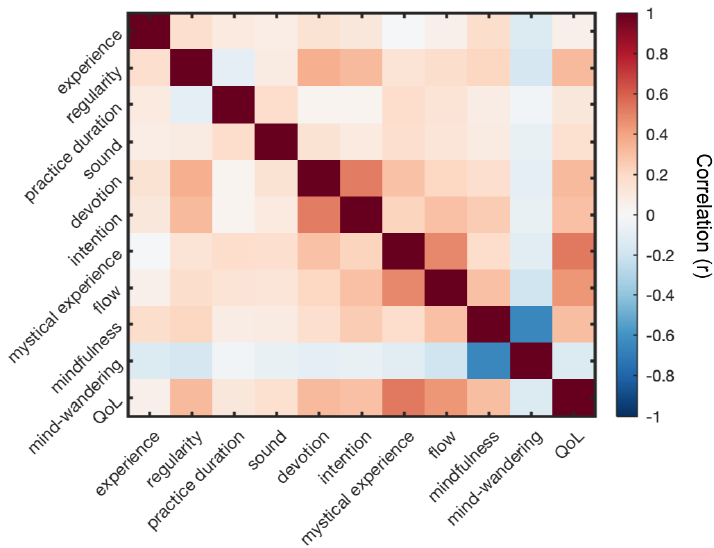
Figure 1. Correlation Matrix of Attributes of Chanting and Psychological